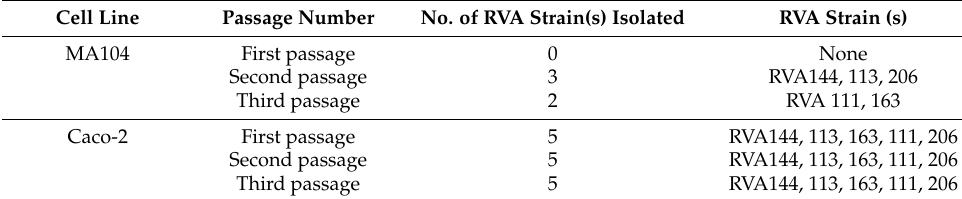
Table 2. Propagation of positive rotavirus samples * using MA104 and Caco-2 cell lines.